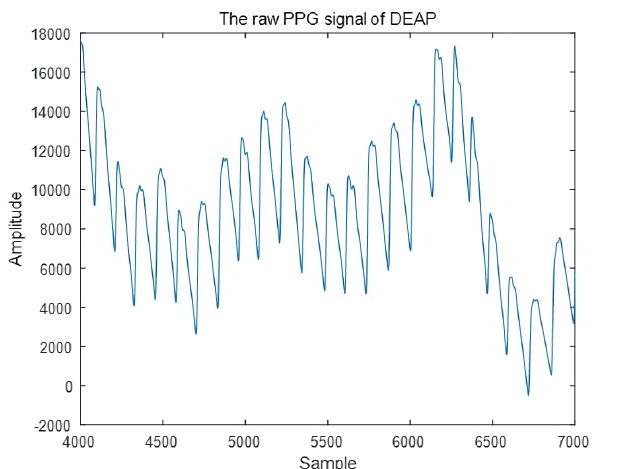
Figure 5. PPG signal of dataset for emotion analysis using physiological (DEAP).